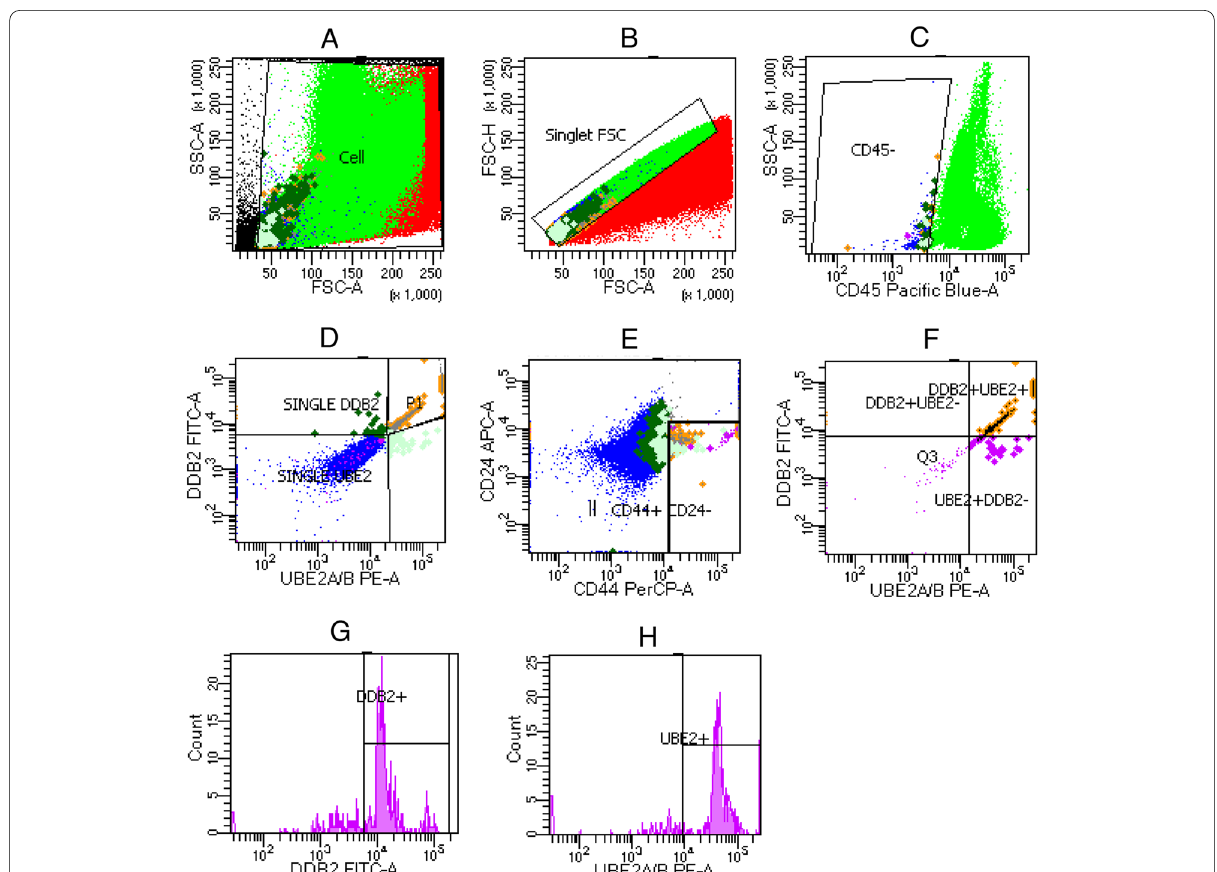
Fig. 1 The flow cytometry pictures with automated flow cytometer. A Expression of total cells. B Expression of singlet FSC. C Expression of CD45. D Expression of UBE2A/B. E Expression of CD44 expression. F Expression of UBE2A/B. G Graphics of DDB2 cell count. H Graphics of UBE2A/B-cell count